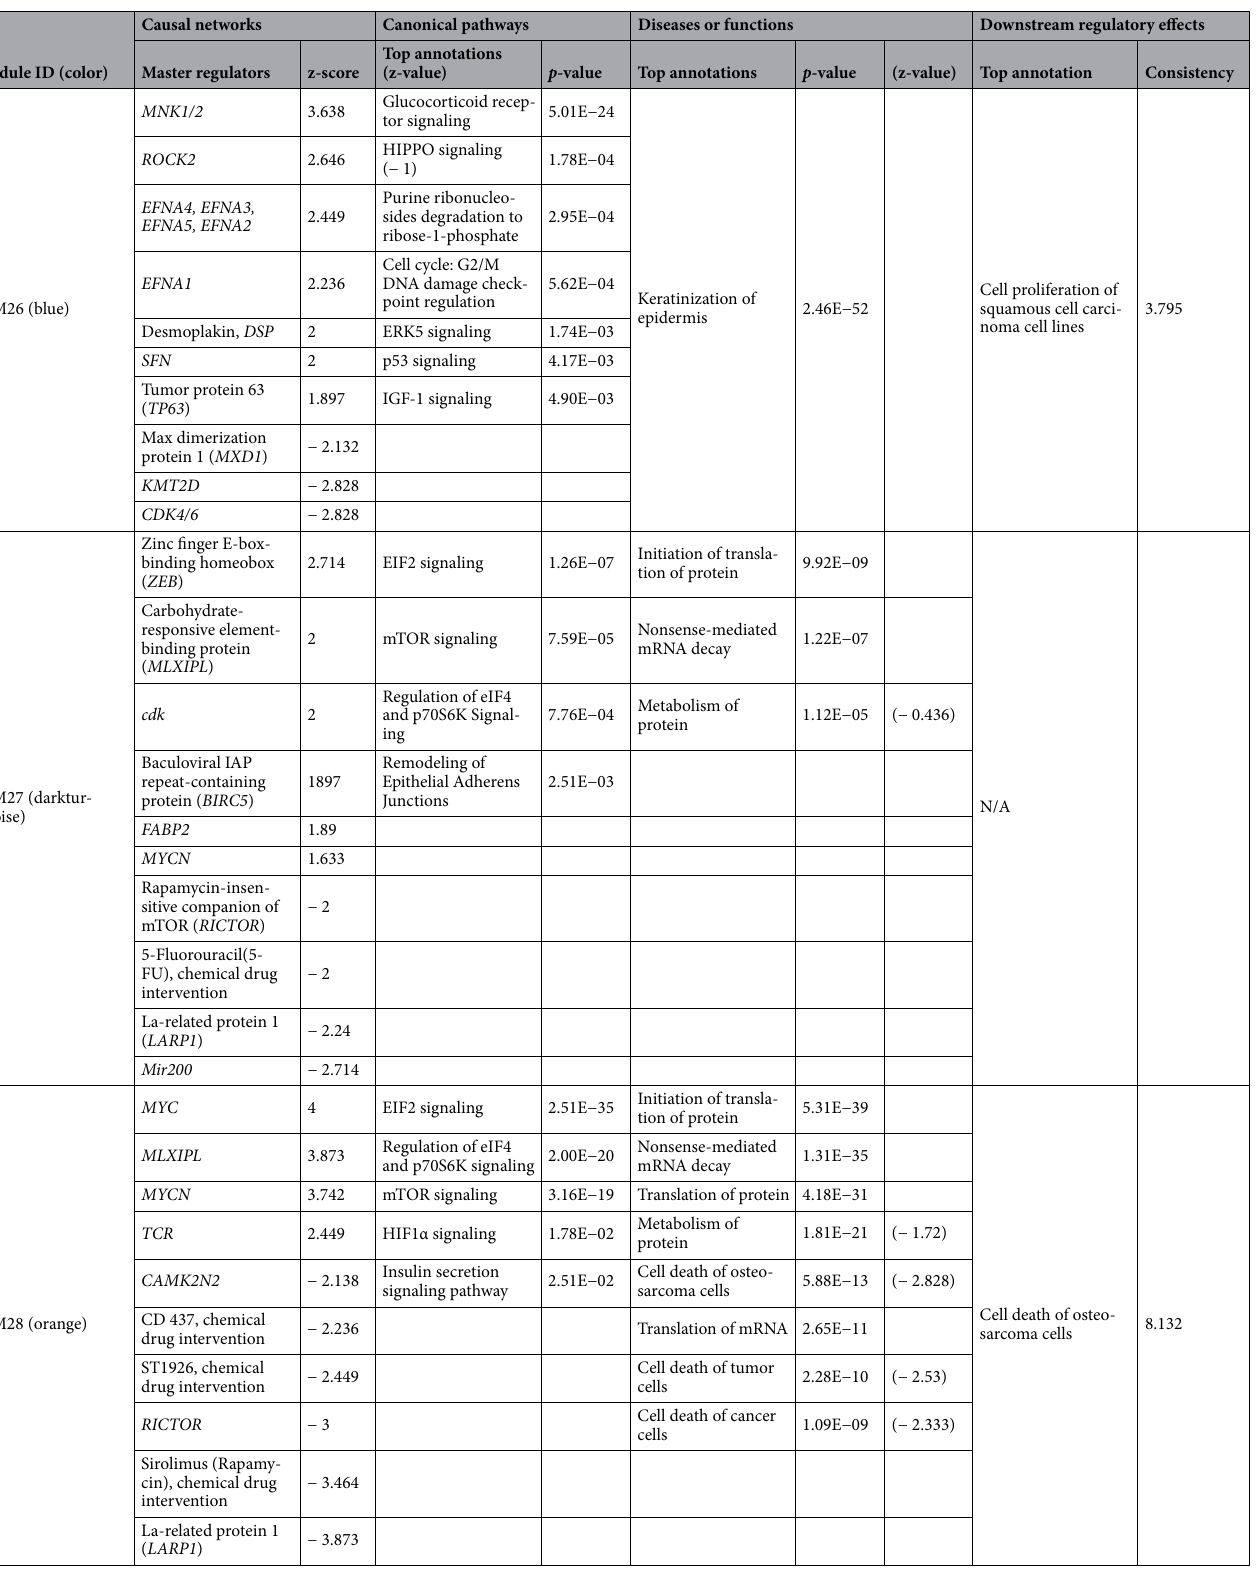
Table 2. Representative master regulators predicted to be activated or inhibited (|z-value|> 2.0) and upregulated (1.5 < z-value < 2.0) are summarized for the three WGCNA modules significant to lung